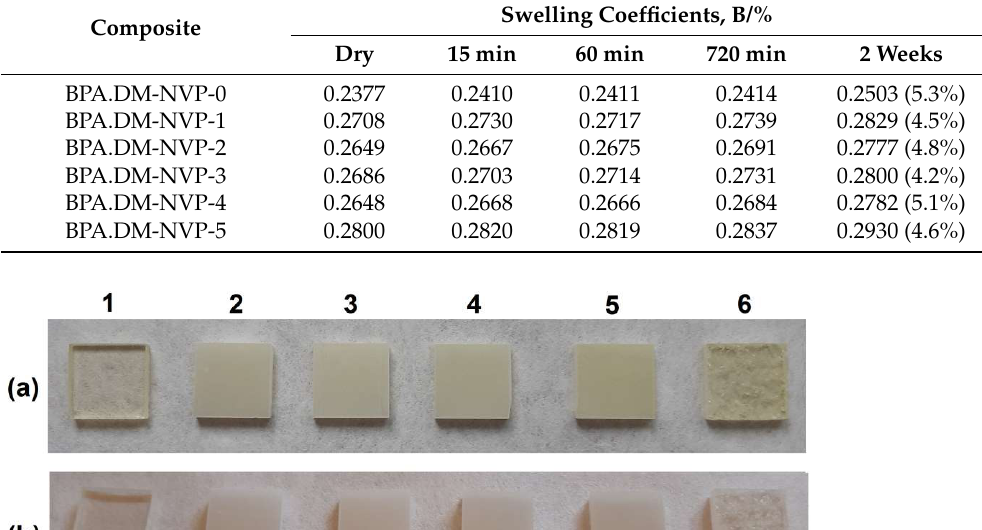
Table 2. Swelling studies results.